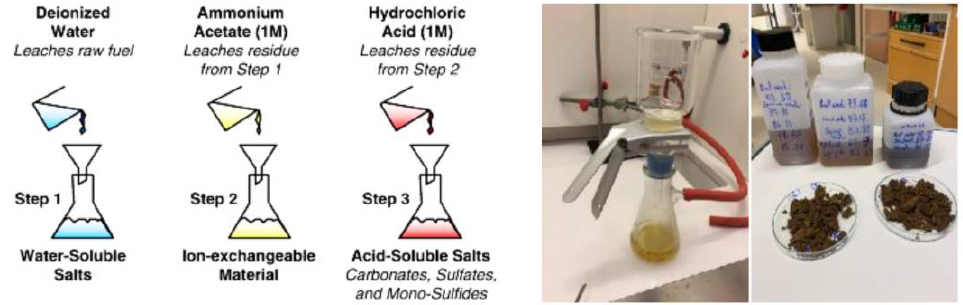
Figure 3. Chemical fractionation procedure of solid fuel.